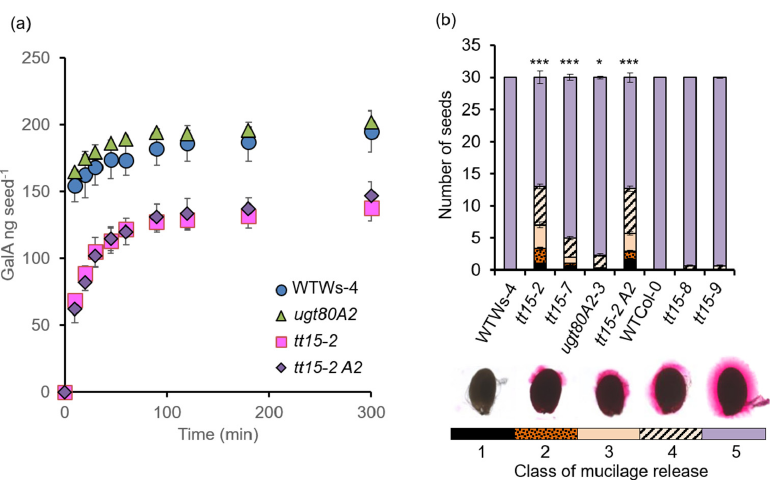
Figure 3. Seed mucilage release is delayed and heterogeneous in tt15 mutants. ( a ) Rate of mucilage release in water as measured by the amount of released GalA sugars. Error bars represent SD values of 3 biological replicates. ( b ) Quantification of different classes of mucilage release observed on ruthenium red staining of seeds after imbibition in water for 16 h. Five different classes (1 to 5) of mucilage release were assigned according to images of seeds shown with corresponding shading on the graph indicated in bars beneath the images. Error bars represent SE values (n = 3). Kruskal-Wallis rank sum test comparing to wild type *** p < 0.001, * p < 0.05. Similar results were obtained in an independent experiment using biological replicates for each genotype. Wild-type, WT; tt15-2 ugt80A2-3 , tt15-2 A2 .